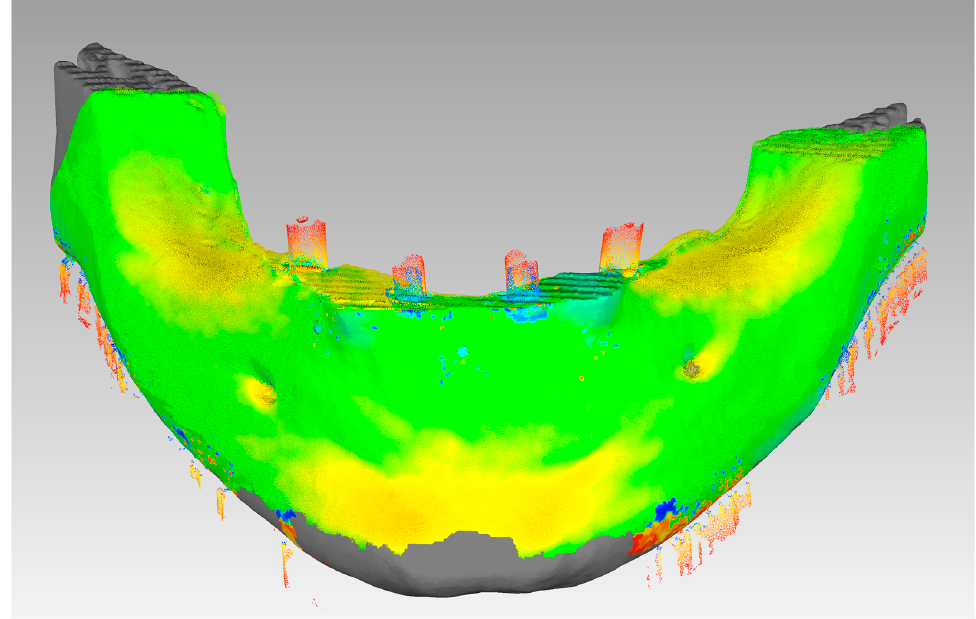
Figure 5. Original STL file exported from segmentation superimposed with the STL file of the printed and scanned mandible with implants and scan body inserted.